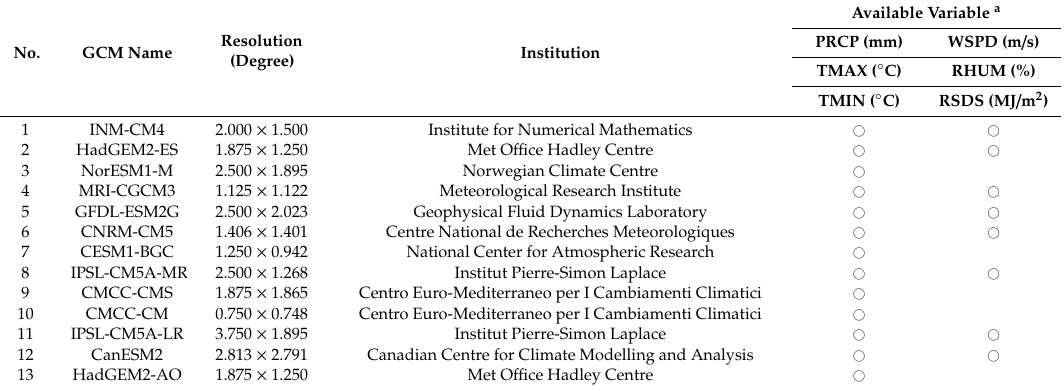
Table 1. Coupled Model Intercomparison Project 5 (CMIP5) global climate model (GCM) description in this study: model name, resolution, institution, and available